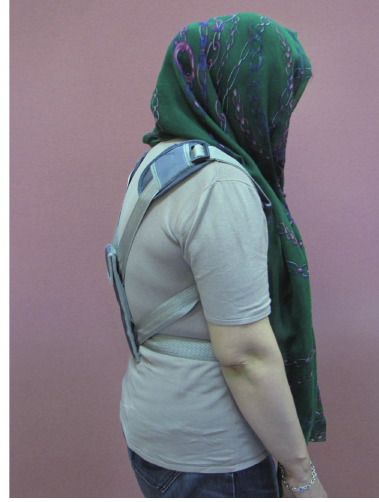
Figure 1: Patient wearing WKO (back view). Figure 2: Patient wearing WKO (side